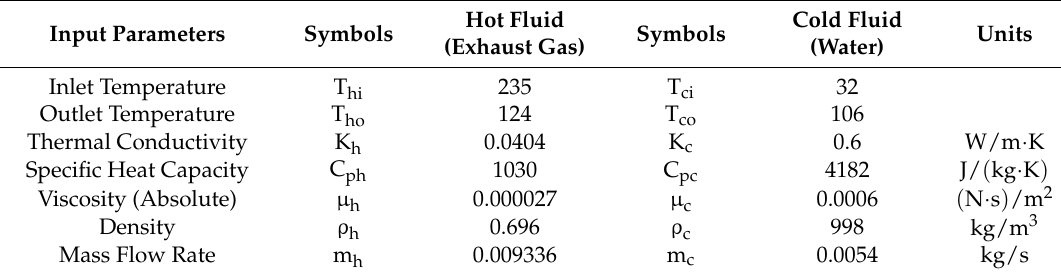
Table 3. Properties of hot and cold fluids.